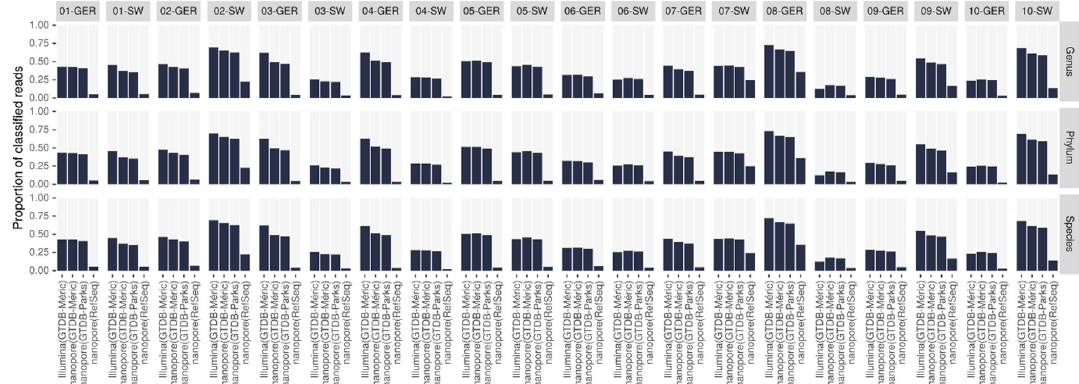
Figure 3. Proportion of taxonomically classified reads of each reactor sample at phylum, genus, and species levels after filtering. The four columns for each reactor represent different read classification approaches. The first bar represents Illumina reads using the Genome Taxonomy Database (GTDB)-Méric index for direct comparison against nanopore sequencing.